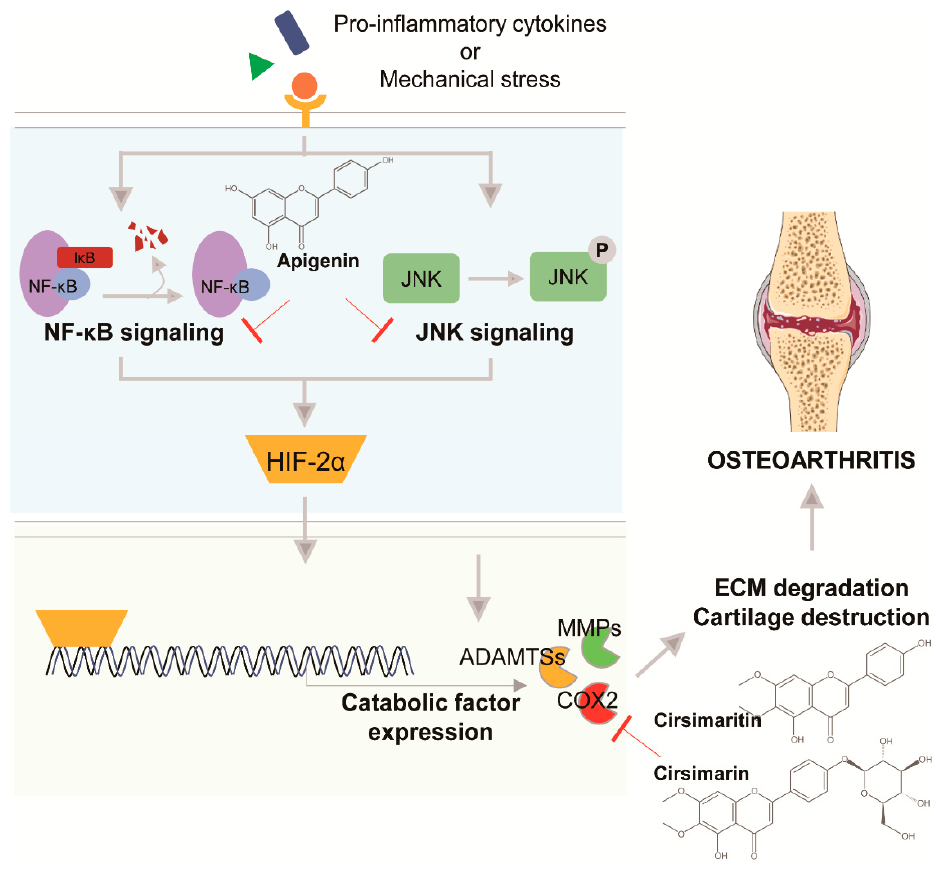
Figure 2. Mechanism of action of apigenin, cirsimarin, and cirsimaritin. Jaceosidin Cirsimarin and